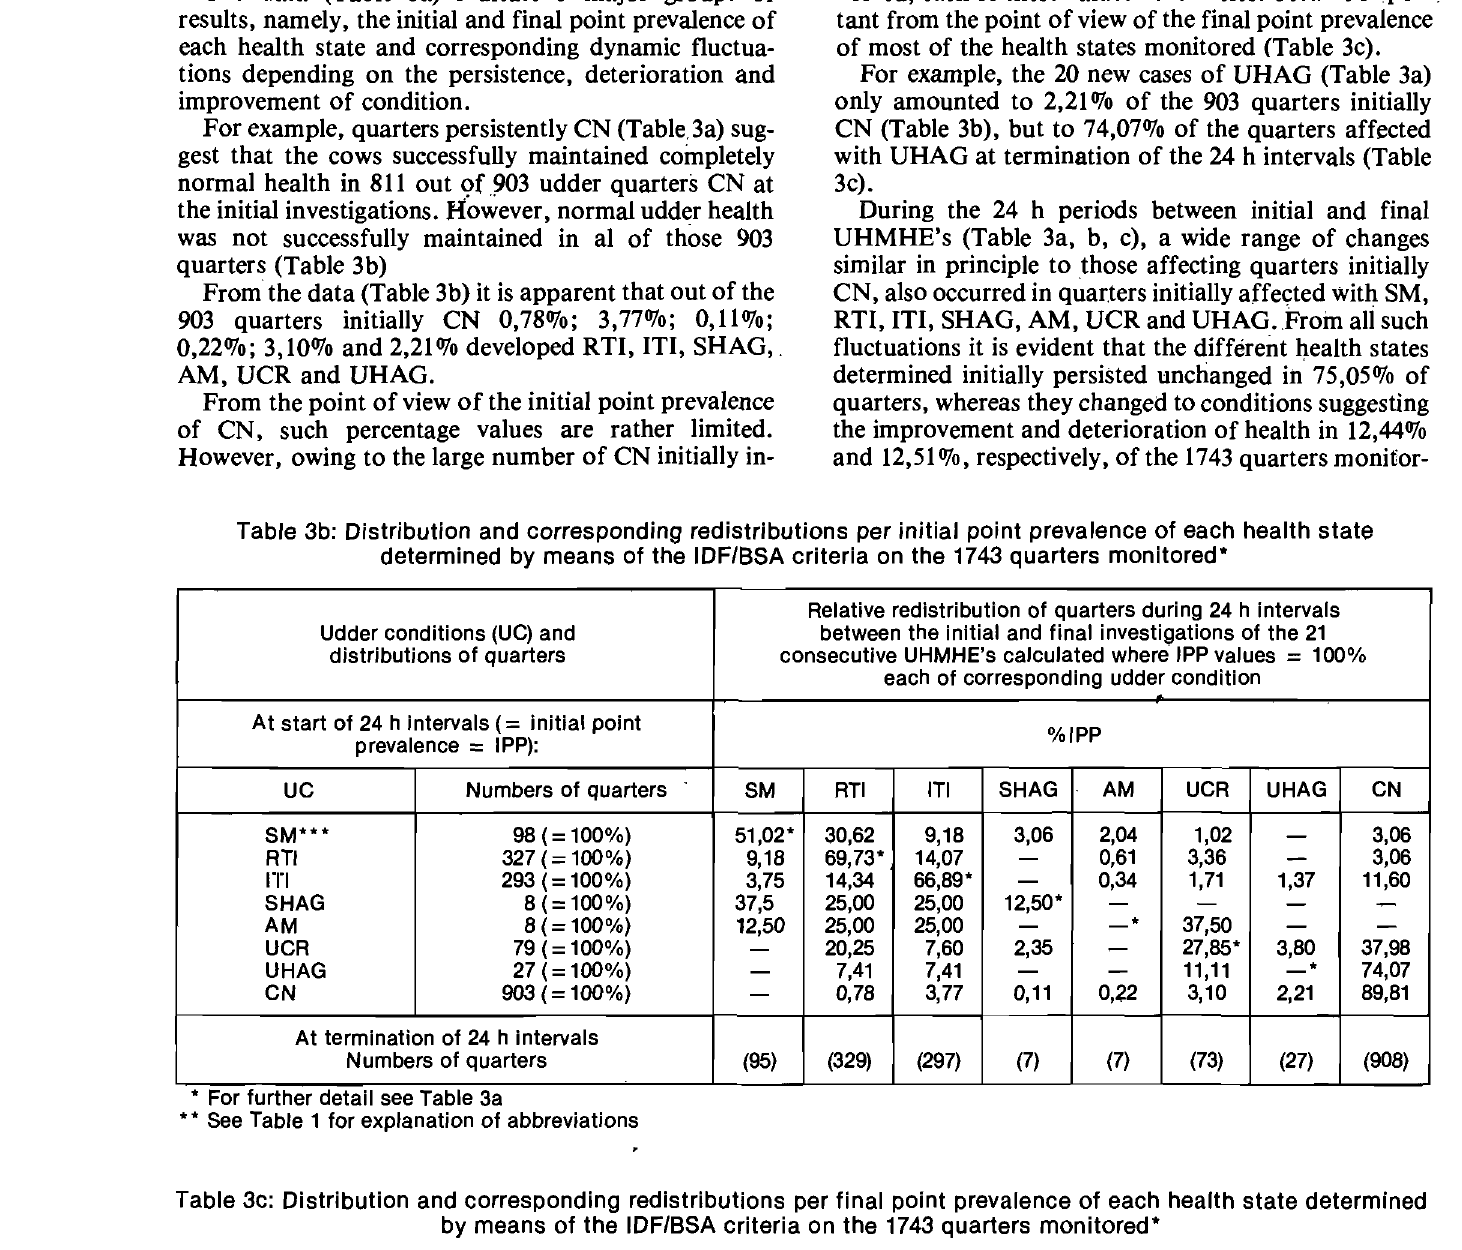
Table 3c: Distribution and corresponding redistributions per final point prevalence of each health state determined by means of the IDF/BSA criteria on the 1743 quarters monitored* Relative redistribution of quarters during 24 h intervals Udder conditions (UC) and between the initial and final investigations of the 21 , distributions of quarters consecutive UHMHE's calculated where FPP values = 100% each of corresponding udder condition At start of 24 h intervals (= initial